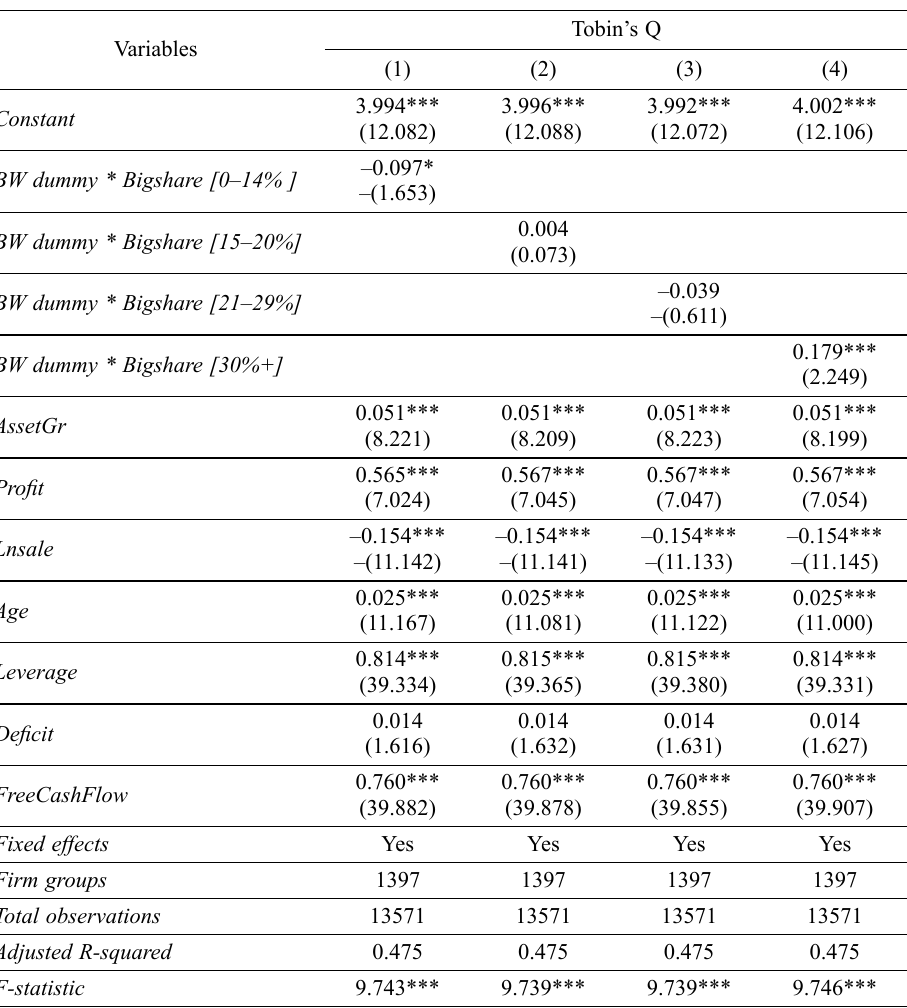
Table 4. Effect on firm value of changes of large shareholder